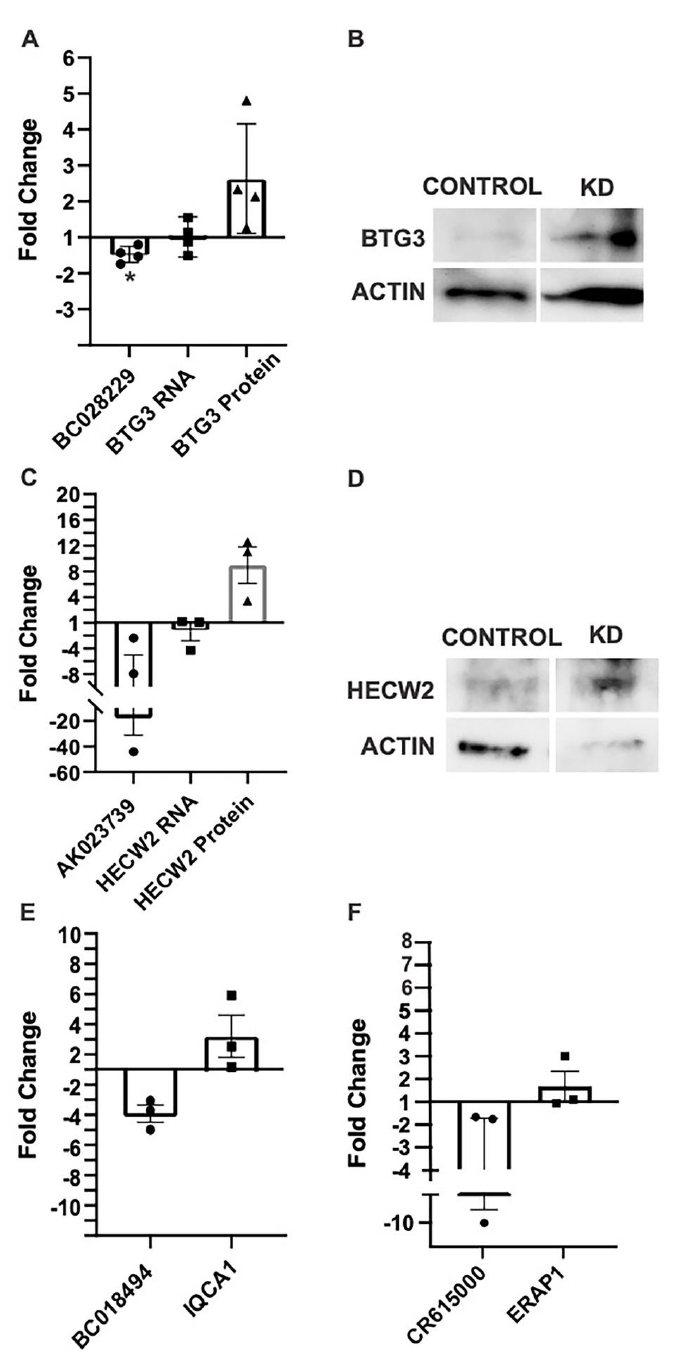
Figure 6. Antisense lncRNAs negatively modulate the expression of their overlapping protein-coding genes in vitro. ( A ) siRNA knockdown of BC028229 in Sh-SY5Y cells results in a significant decrease in BC028229 (* p < 0.05 one sample t -test, n = 4) and an increase in the expression of BTG3 mRNA via qPCR and ( B ) an increase in the expression of BTG3 protein via Western blot ( p = 0.12, one sample t -test, n = 4). ( C ) siRNA knockdown of AK023739 results in a decrease in AK023739 and ( D ) an increase in the expression of HECW2 protein, as shown by Western blot ( p = 0.12, one sample t -test, n = 4). ( E ) Knockdown of BC018494 results in a significant decrease in BC018494 ( p < 0.05, one sample t -test, n = 3) and an increase in the expression of IQCA1 mRNA, as shown byqPCR (mean = 3.27, p = 0.25, one sample t -test, n = 3). ( F ) CR61500 knockdown results in no significant changes in ERAP1 expression. All results are a fold change in comparison to mock transfection